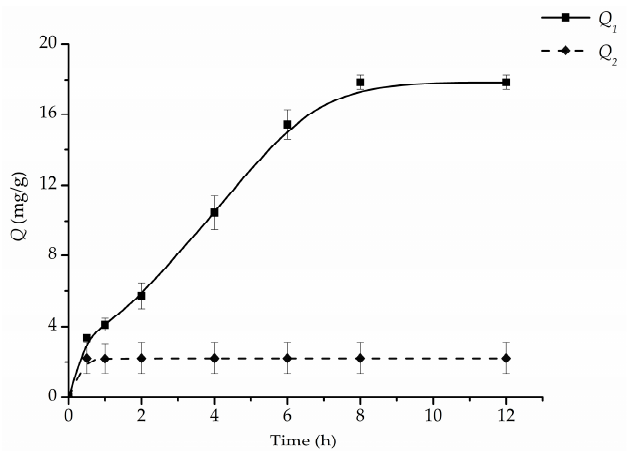
Figure 6. Dynamic adsorption of hypericin on Fe 3 O 4 @PDA/Hyp and Fe 3 O 4 @PDA NSs.